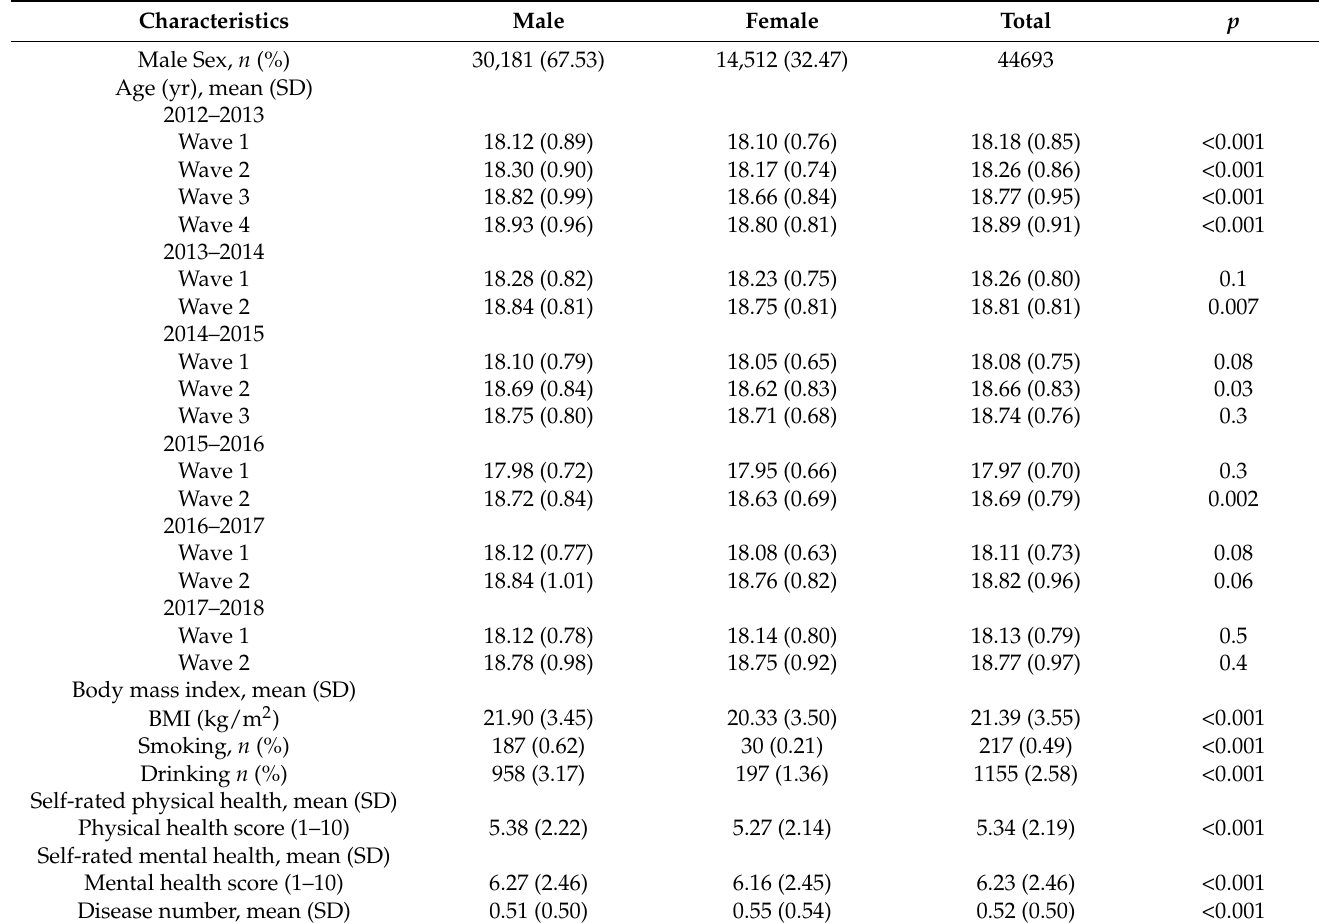
Table 1. Baseline characteristics of survey